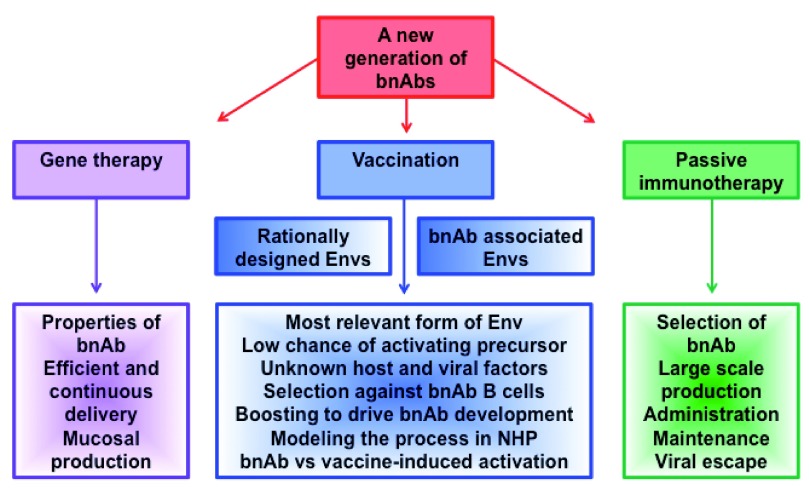
Three promising avenues for using HIV-1 broadly neutralizing antibodies (bNAbs) for protection and therapy.Each area of pursuit is shown, and potential obstacles are listed below. For vaccination, there are two approaches for generating immunogens that will face common barriers. Env, envelope glycoprotein; NHP, non-human primate.